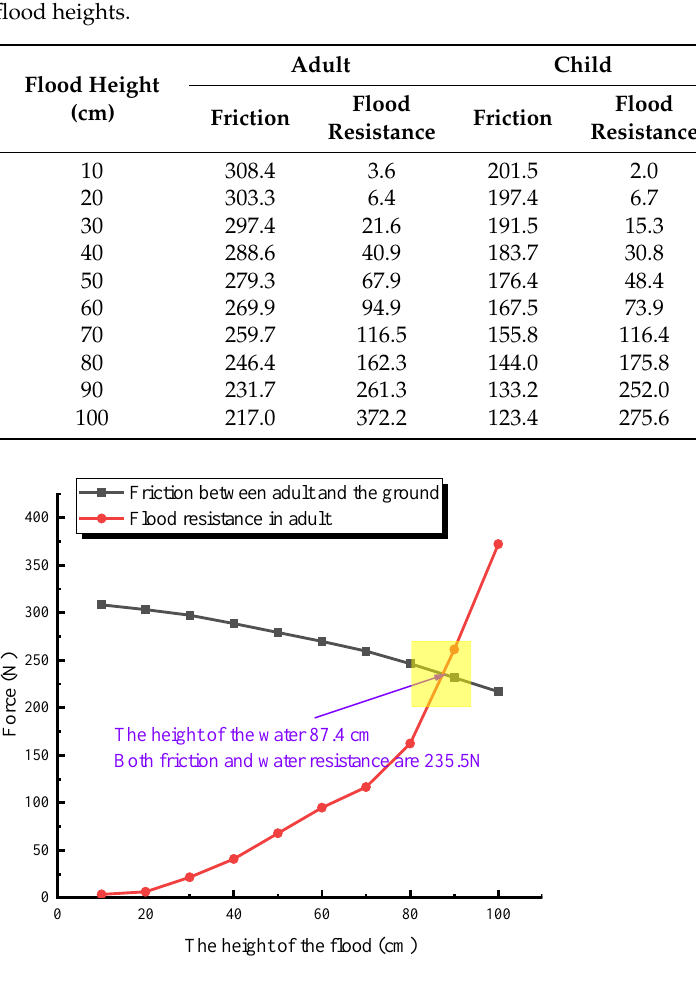
Figure 22. Curve comparison of the flood resistance and friction (adult).